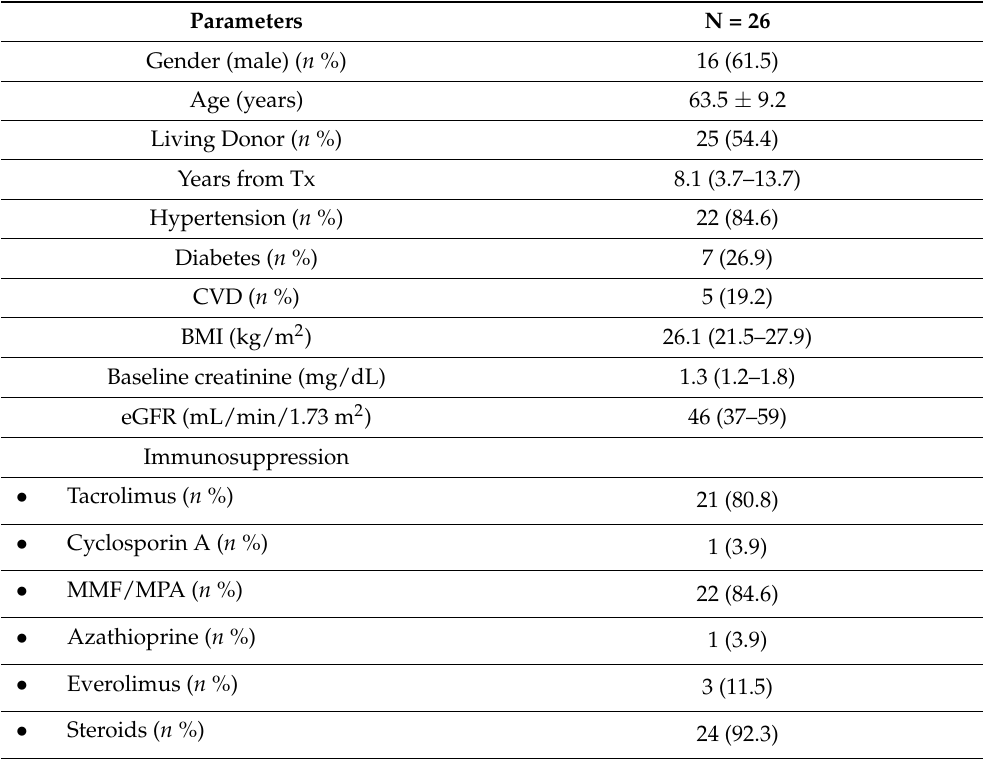
Table 4. Baseline characteristics of patients with moderate–severe